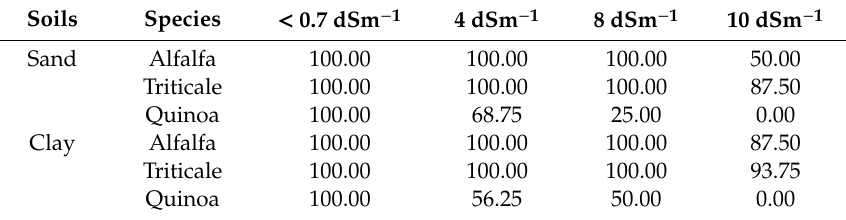
Table 6. Percentage of experimental units where some emergence was observed for species × soils × salinity species combinations for alfalfa, triticale, and quinoa in two soil types; sand and clay at four different salinity levels.